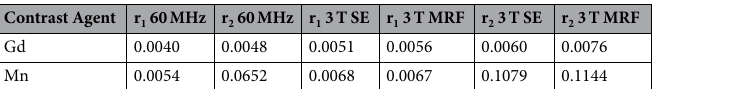
Table 1. Comparison of relaxivity measurements (r 1 , r 2 ) in mM − 1 ms − 1 for each contrast agent in deionized water at room temperature between 60 MHz * , 3 T spin echo (SE), and 3 T MRF. * 60 MHz measurements made at 37 °C.